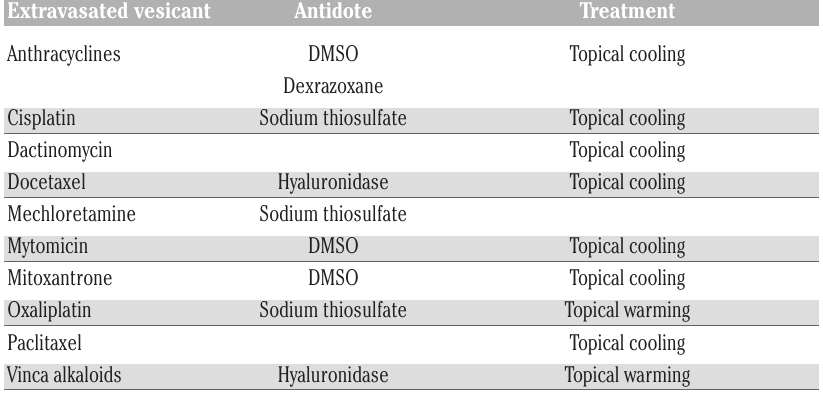
Table 3. Antidotes and